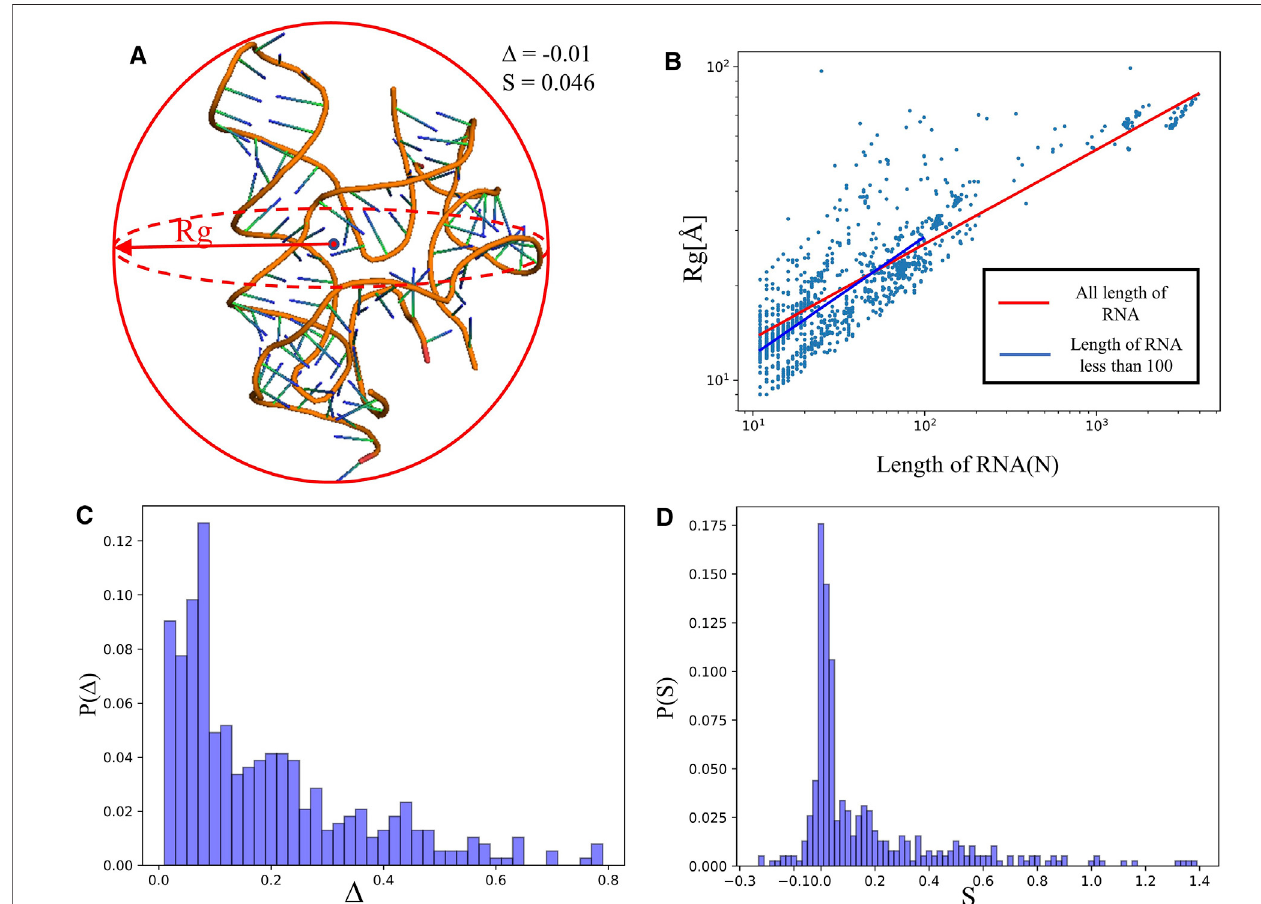
FIGURE 2 | (A) The schematic diagram of size and shape for an RNA 3D structure (PDB ID: 4QLM). R g is the radius of gyration, Δ represents the asphericity parameter and S is the shape parameter, and their values are calculated by the RNAStat ( Eqs 1 – 4 ). The 3D structure of 4QLM is shown with the PyMol (http://www. pymol.org). (B) Radius of gyration ( R g ) as a function of length of RNA ( N ). Dots: R ’ g s of RNA structures in our dataset. Red line: the best- fi t line to the data that shows the scalinglaw R g (cid:1) 6 . 7 L 0 . 31 .Blueline:thebest- fi tline( R g (cid:1) 5 . 1 L 0 . 37 )tothedataforRNAswithlengthlessthan100 nt. (C,D) Distributionsoftheasphericityparameter Δ (C) and shape parameter S (D) for RNA structures in our